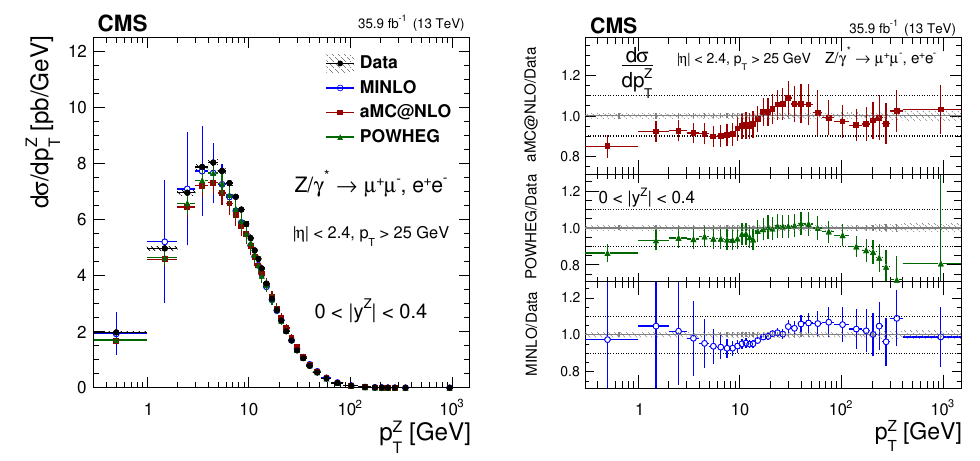
Figure 9 . The measured absolute cross sections (left) in bins of p Z for the 0 : 0 < j y Z j < 0 : 4 region. T The ratios of the predictions to the data are also shown (right). The shaded bands around the data points (black) correspond to the total experimental uncertainty. The measurement is compared to the predictions with MadGraph 5 a mc@nlo (square red markers), powheg (green triangles), and powheg - MINLO (blue circles). The error bands around the predictions correspond to the combined statistical, PDF, and scale uncertainties.